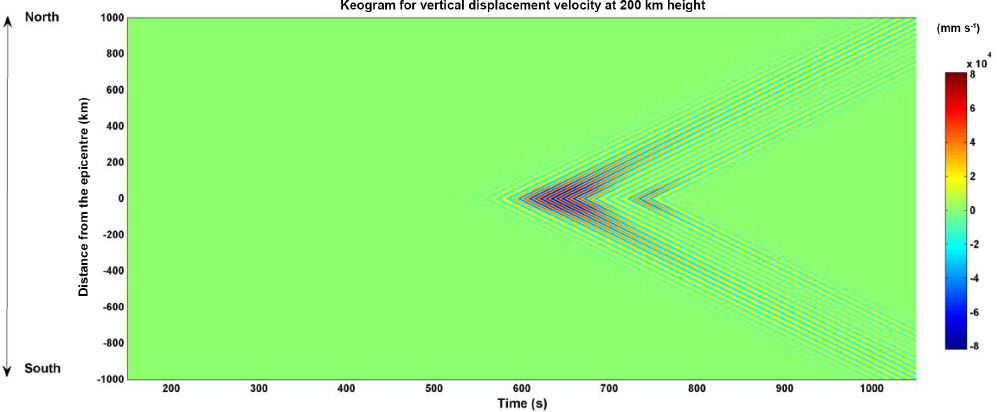
Figure 5. Displacement–time diagram (keogram) of the infrasound propagation at 200km height. The north and south arms of the keogram for the vertical particle velocity are identical, as the Rayleigh wave propagation is considered symmetric in both the north and south